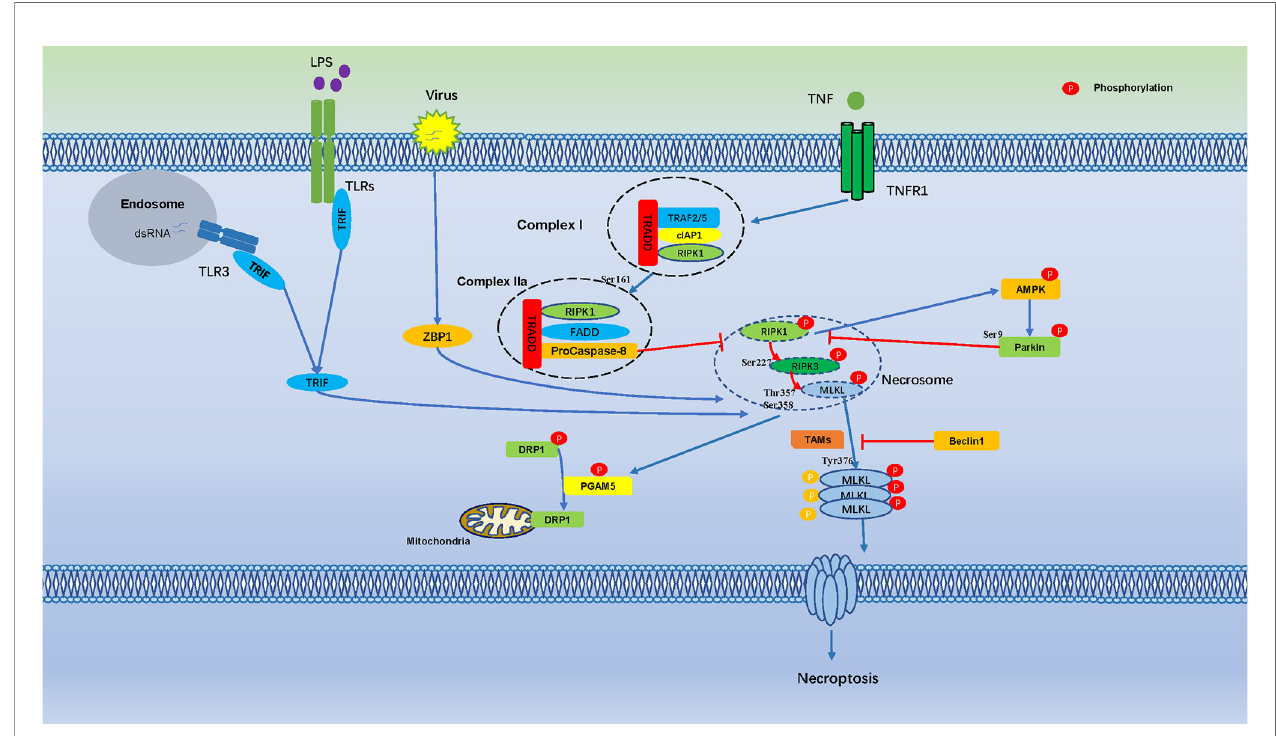
FIGURE 1 | Cell Necroptosis is Regulated by Numerous Phosphorylation Events. Phosphorylation regulates cell necroptosis through numerous phosphorylation events, TNF bind to TNFR1 on the cell membrane and recruit a series of proteins to form complex I, which is includes TNFR-associated death domain (TRADD), RIPK1, TRAF2, the cellular inhibitor of apoptosis protein 1 (cIAP1). Autophosphorylation of RIPK1 leads to its enzymatic activation, Ser161 of RIPK1 is an important autophosphorylation sites, which triggers RIPK3 phosphorylation, the phosphorylation of Ser227 of RIPK3 triggers MLKL recruitment to the necrosome, which phosphorylates MLKL in Ser358, Thr357, and induces necroptosis. AMPK is activated by RIPKs and subsequently phosphorylates Parkin ’ s Ser9, which is inhibits phosphorylation of RIPK3. Necrosome promotes phosphorylation of PGAM5, which induces dephosphorylation of